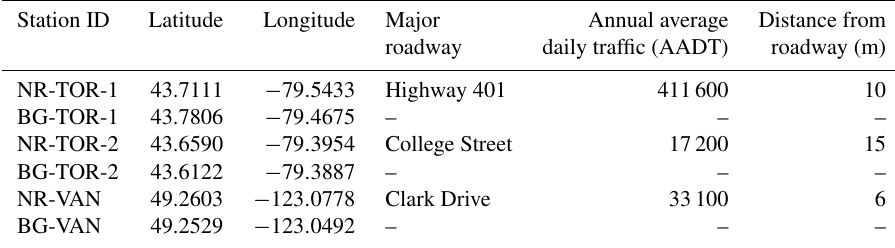
Table 1. IDs, locations, name of major roadway, and average daily traffic intensity for each monitoring location. Station ID Latitude Longitude Major roadway